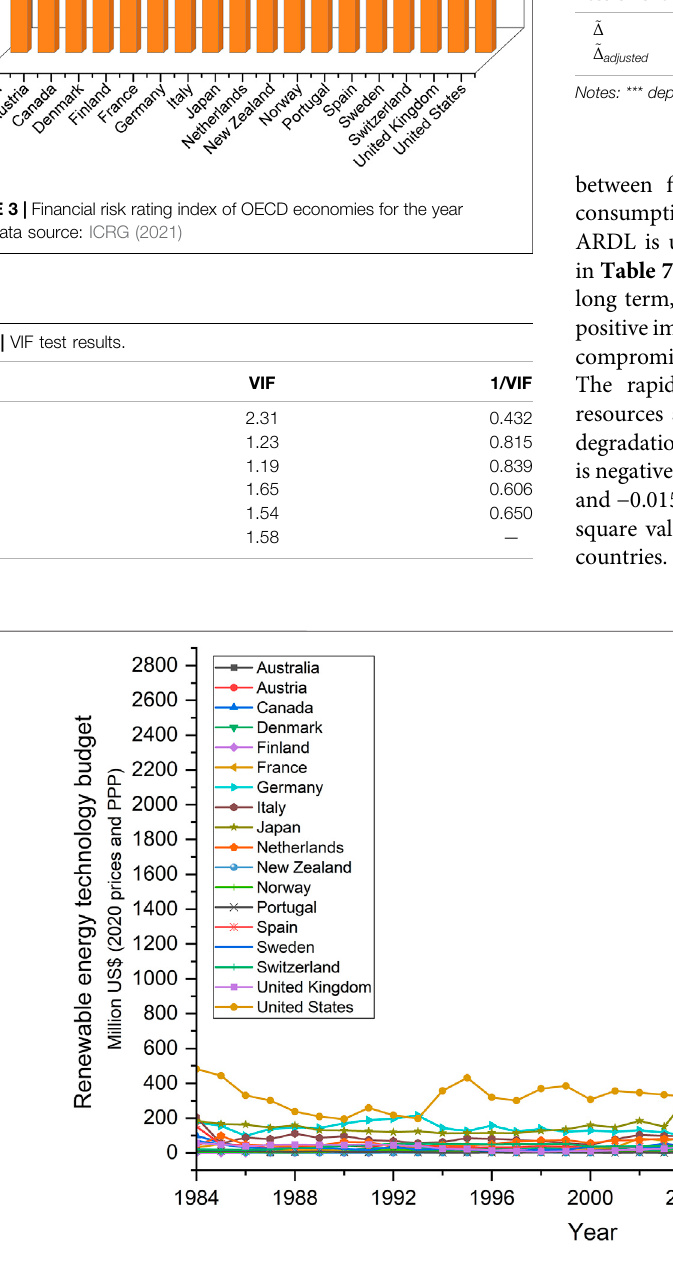
FIGURE 4 | Trends in renewable energy technology budget in OECD countries from 1984 to 2018. Data source: IEA (2022)